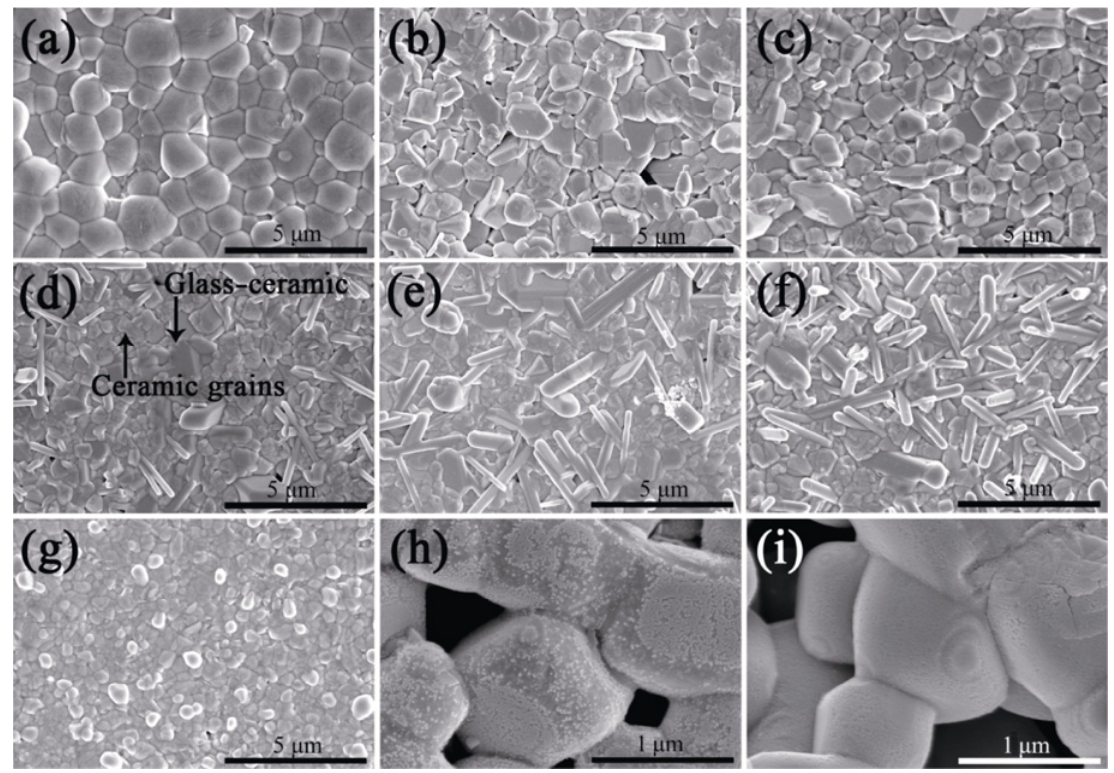
Fig. 2 SEM images of BS 0.5 BNT– x GS ceramic composites after thermally etching with x = (a) 0, (b) 2, (c) 6, (d) 10, (e) 14, (f) 16, and (g) 18. (h, i) SEM images of BS 0.5 BNT–6GS and BS 0.5 BNT–14GS ceramic composites acid etched by 5% HF,